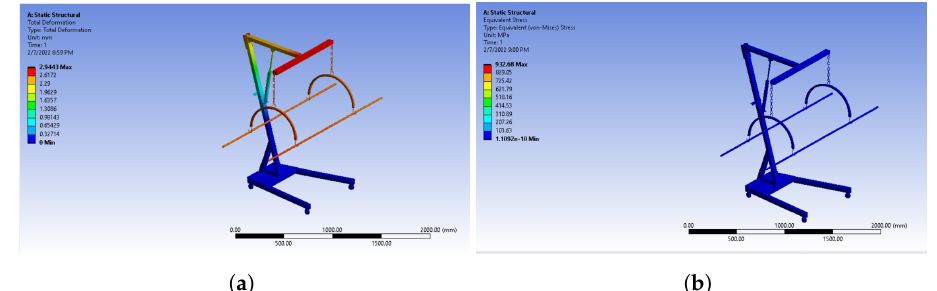
Figure 12. ( a ) Equivalent stress and ( b ) total deformation using stainless steel.